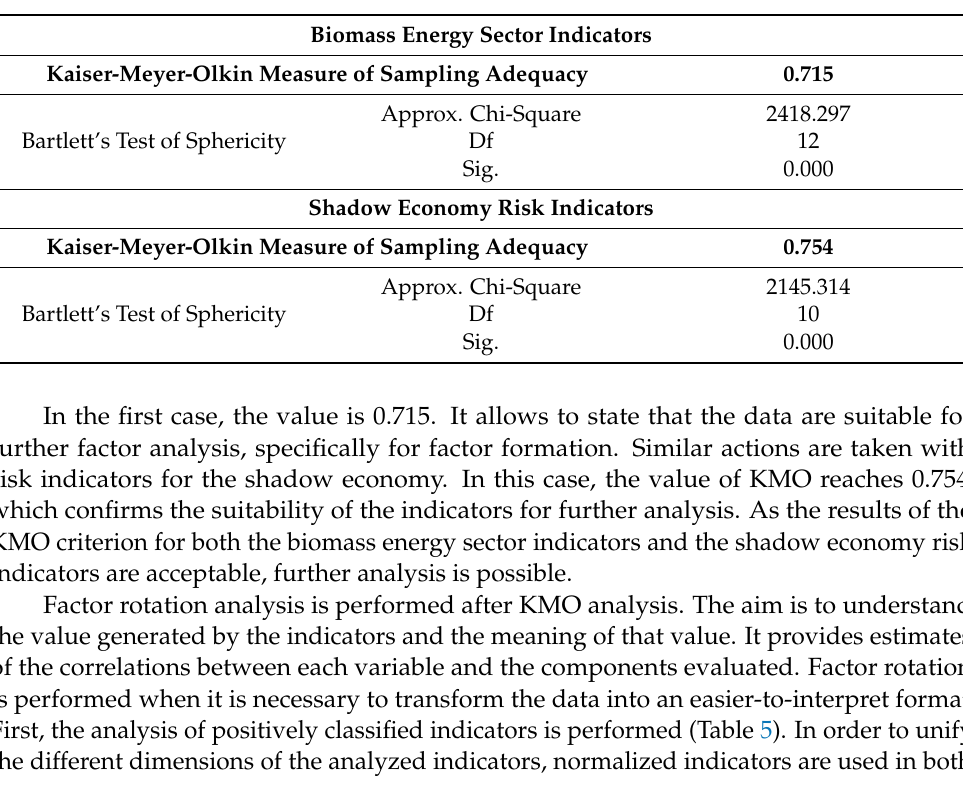
Table 4. Results of KMO